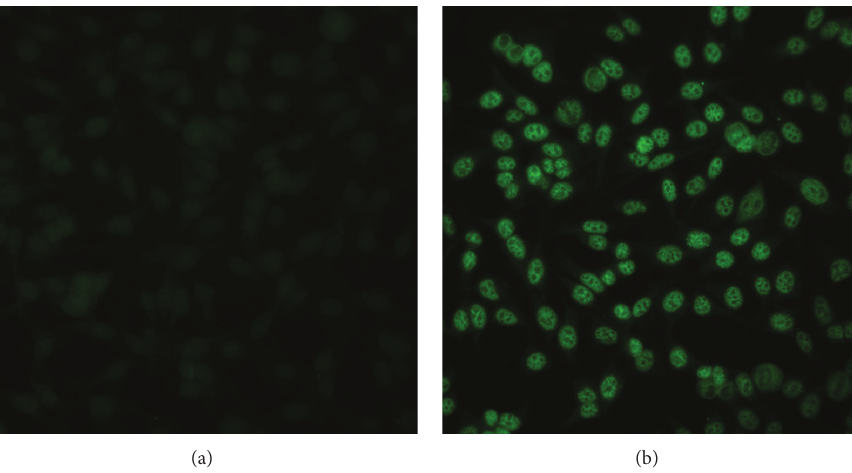
Figure 3: Examples of ANA determination by immunofluorescence. Human sera were incubated with HEp-2 cells followed by fluorescent anti-human IgG. The sample on the left (a) is ANA negative, while the sample on the right (b) was considered 2+ ANA positive, showing fine speckled nuclear staining sparing the